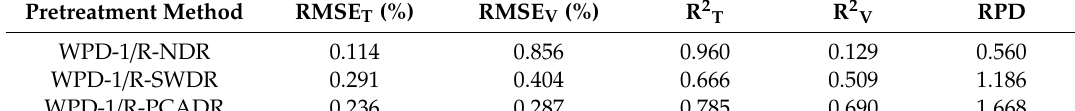
Table 6. Comparison of SOM Content Estimation Results for Spectral Data Subjected to 1/R Transformation, WPD Denoising, and Different Dimensionality Reduction Methods.